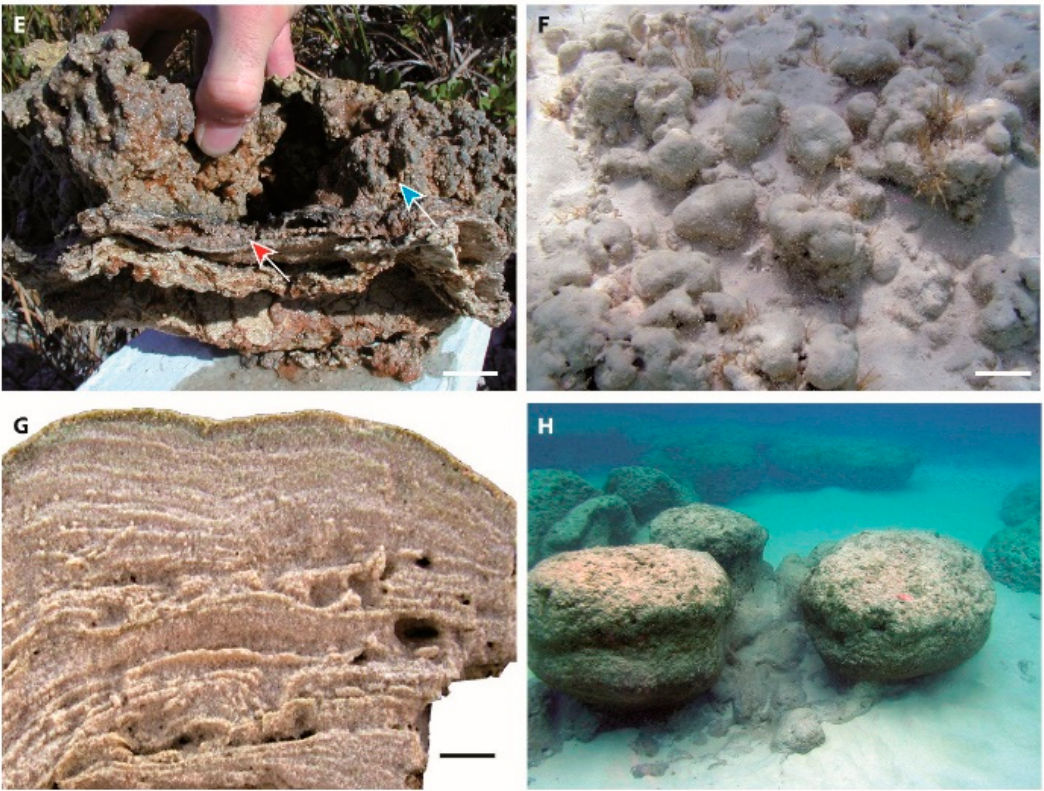
Figure 18. Macro- and meso-fabrics of modern microbialites from hypersaline lake and open marine environments, Bahamas and Cuba. ( A ) Patches of Scytonema knobs/hemispheroids in shallow and highly turbid hypersaline waters (Storr’s Lake, San Salvador Island). ( B ) Cross-section Scytonema -rich hemispheroid to knobby stromatolite (see A), showing fine lamination composed of high magnesian calcite (Storr’s Lake, San Salvador Island). The scale bar is 1 cm. ( C 1) Lithifying hemispheroid mat covering the bottom of the low energy hypersaline lagoon of Santa Lucia, northern Cuba. The lagoon developed over a Pleistocene coral reef, with mats encrusting dead corals ( C 2). ( D ) Cross-section through a lithifying hemispheroid to crinkle microbial mat from Santa Lucia lagoons (Cuba; see C 1). The top of the mat shows a green lamina corresponding to the oxygenic photosynthesis zone dominated by cyanobacteria. It overlies a red lamina rich in purple sulfur bacteria performing anoxygenic photosynthesis. Below, white microbially-induced carbonate precipitates (high magnesian calcite mostly) plus “trapped and bound” particles from storm deposits contrast with dark (organic-rich) laminae. A light grey bioclastic mud is visible below the mat. The scale bar is 2 cm. ( E ) Section through a large microbialite crust developing in the deeper (northern) part of Storr’s Lake (San Salvador Island). The sample shows an alternation of stromatolitic (red arrow) and thrombolitic (blue arrow) mesofabrics that could be related to seasonal changes in water depth and the associated increase in turbidity, which are common in this hypersaline lake. The scale bar is 2 cm. ( F ) Small stromatolitic branches developing on the normal marine, high energy beach of Highborne Cay. The scale bar is 5 cm. ( G ) Cross-section through a small stromatolitic column from Highborne Cay (Bahamas) that shows well-developed lamination. The stromatolite is mainly composed of “trapped and bound” particles (ooids and bioclasts). The lamination is produced by the iterative development and rapid lithification through aragonite production of a very thin biofilm that is forming at the top of the sedimentary buildup. The scale bar is 1 cm. ( H ) Large stromatolitic and thrombolitic columns developing in the shallow, sub-tidal environment of Darby Island. The large heads are often organized in ridges or patches visible in the back of the picture. These microbialitic heads are living in open sea conditions and are often perforated by sponges or bivalves, as well as encrusted by green algae (e.g., Batophora ), bryozoans, or corals (e.g., Siderastrea radians ).